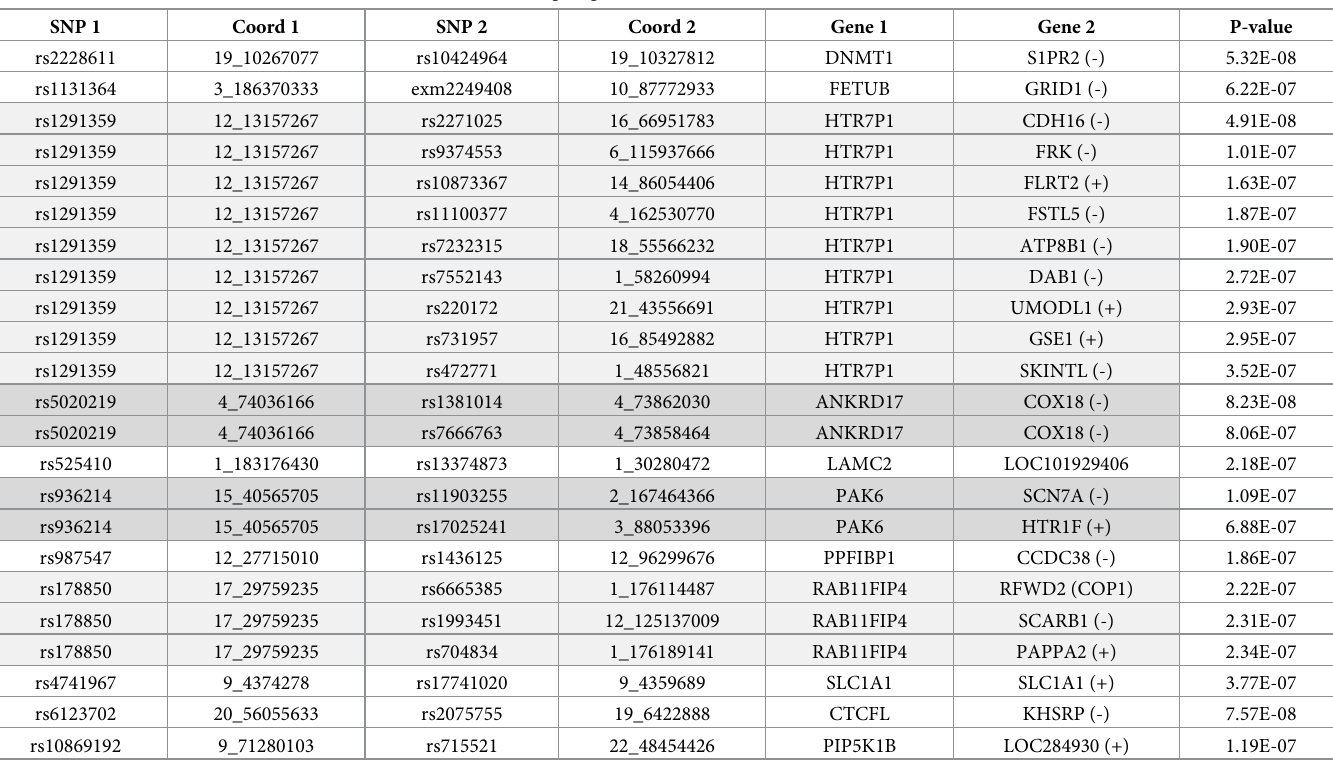
Table 6. Locus interaction effects detected for notable loci exhibiting single locus